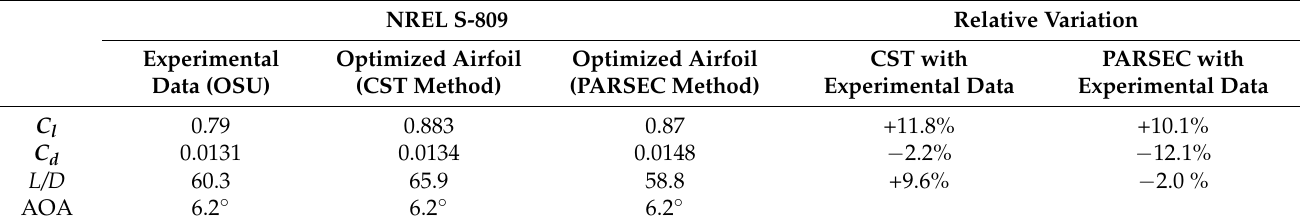
Table 6. Performance comparison of the original and optimized airfoils (NREL S-809). NREL S-809 Relative